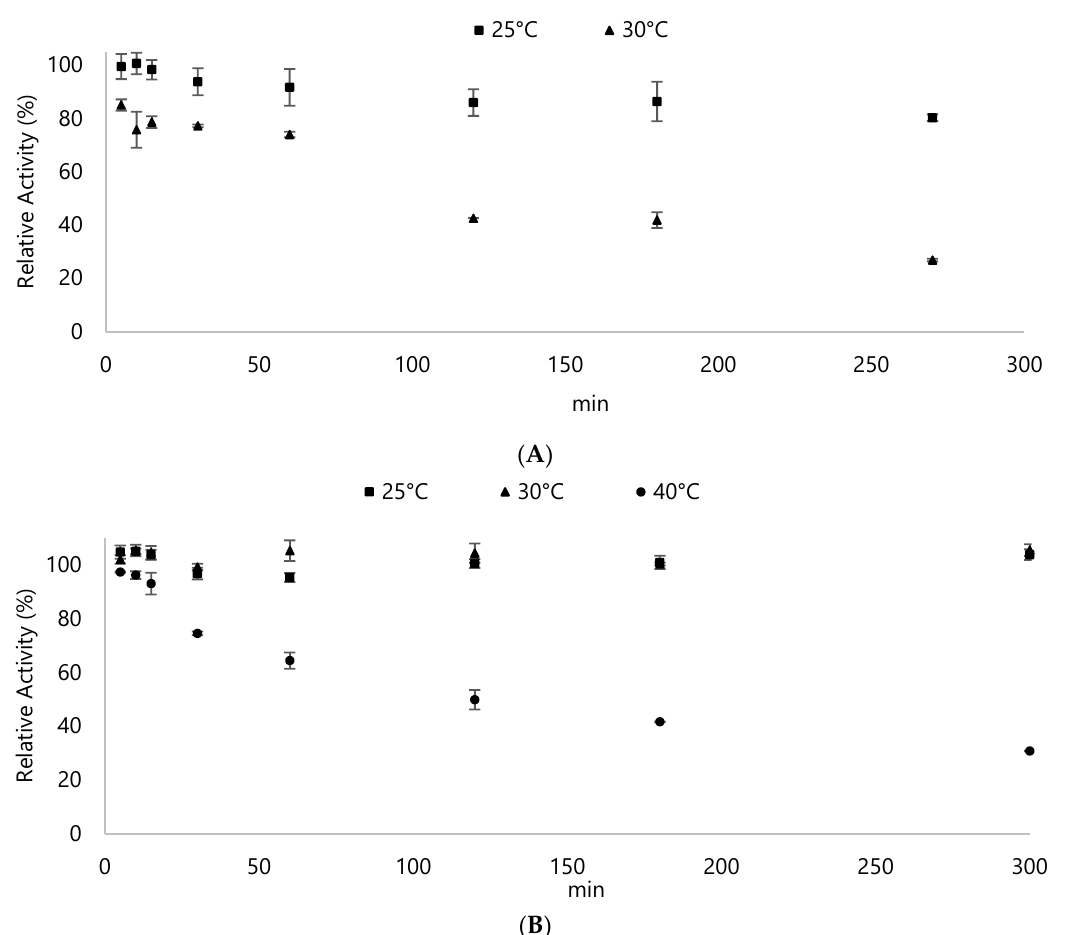
Figure 2. Thermal stability of ( A ) DypA and ( B ) DypB. The enzymes were incubated at different temperatures and subjected to standard ABTS assay to determine changes in the activity. DypA exhibited about 13 U/mg while DypB showed about 12 U/mg. These values represent the 100% so as to compare the relative activity of the enzyme after subsequent incubation to different temperatures. Results for higher temperatures were not shown because the enzyme was rendered inactive immediately. Assay was done in 100 mM potassium phosphate buffer (pH 5), ABTS solution, and 0.2 mM H 2 O 2 .